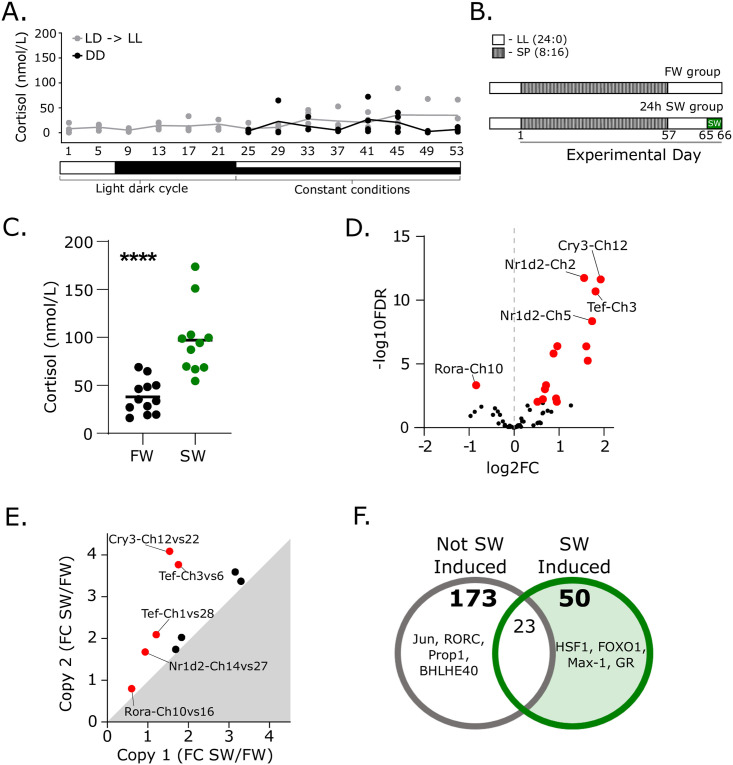
Stress response implicates glucocorticoid receptor signaling in clock ohnologue regulation.A. Diel and circadian profile of plasma cortisol (n = 4). Time axis is given in continuous hours since the start of the experiment, therefore 1 to 21 represent zeitgeber time (ZT) and 25 onwards is equivalent to circadian time (CT)1 to CT29. Due to the sampling protocol time-points 1 and 5 are replotted from time-points 25 and 29. B. Sea-water stress experiment design. LL—constant light, SP—short photoperiod, SW- sea-water challenge. C. Plasma cortisol concentration in blood plasma in sea-water stress experiment (n = 11–12). D. Volcano plot showing sea-water stress regulation of clock genes (n = 6). Significantly regulated transcripts (FDR<0.01) are shown in red. FC—fold change. E. Differential sea-water stress regulation of ohnologue pairs. Significantly different pairs (Analysis of genes where one or both genes are significantly regulated by seawater (FDR<0.01), then submitted to a two-way ANOVA, with sea-water regulation and interaction, p<0.05) are shown in red. F. Predicted transcription factor promoter binding analysis. Both sea-water induced and not-induced gene cohorts were analysed. 50 motifs were specific to the sea-water induced cohort. The top four motifs in each group are displayed.